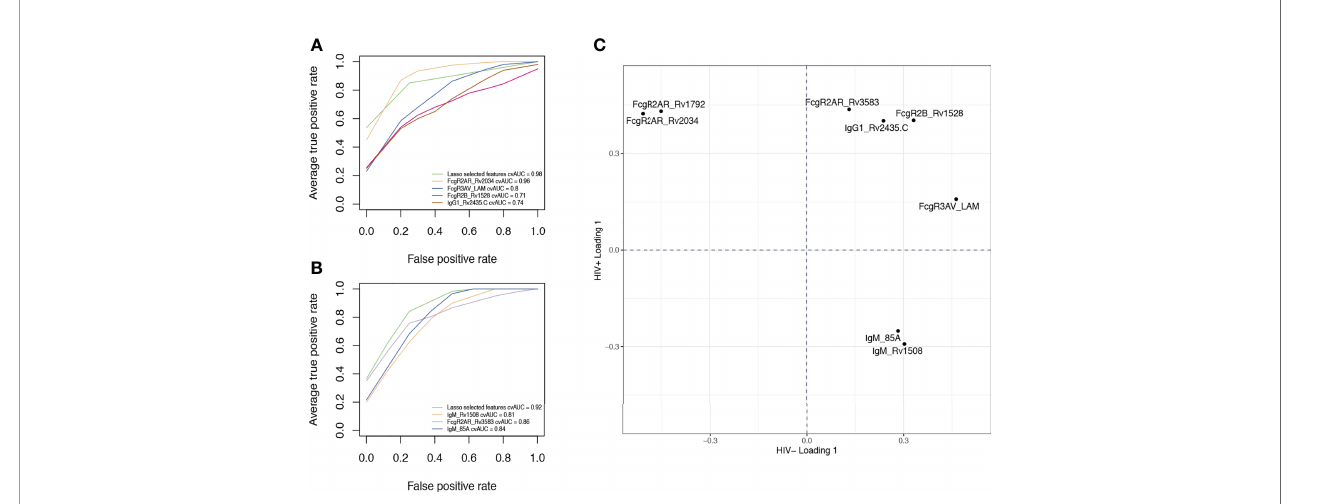
FIGURE 5 | Discriminatory features between ATB and LTB. ROC curves showing the sensitivity and the speci fi city of potential biomarkers discriminating ATB and LTB in HIV negative (A) and positive (B) populations. (C) Loading plot showing LASSO-selected features enriched in ATB, both among HIV negative and HIV positive individuals (upper right quadrant) versus those enriched in LTB among HIV negative and HIV positive groups (low-left quadrant). Features in the upper left quadrant are increased in ATB compared to LTB among HIV+ but are enriched in LTB among HIV-. Features in the low right quadrant are enriched in LTB compared to ATB among HIV+ but are higher in ATB among